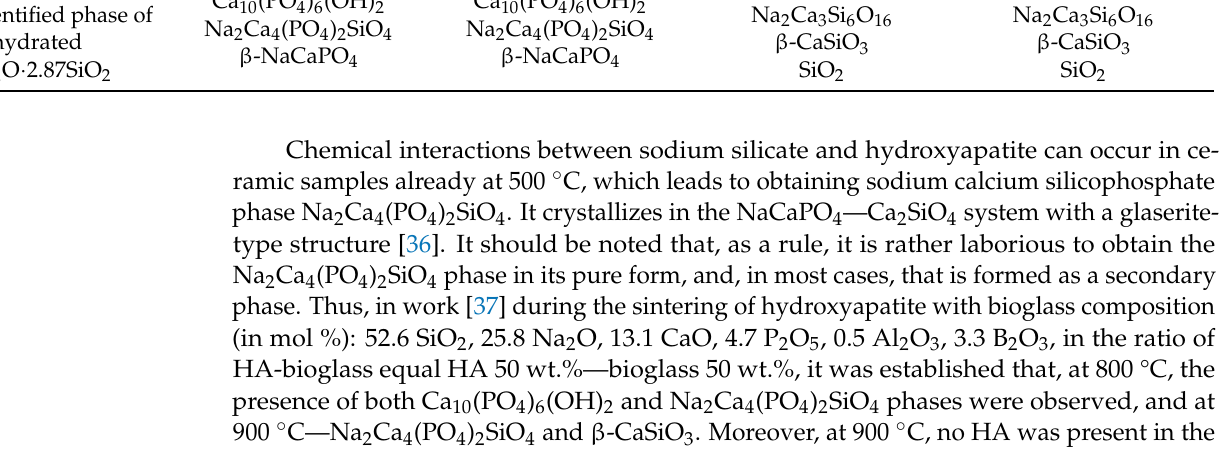
According to the XRD data, the ceramic samples obtained from pre-ceramic samples